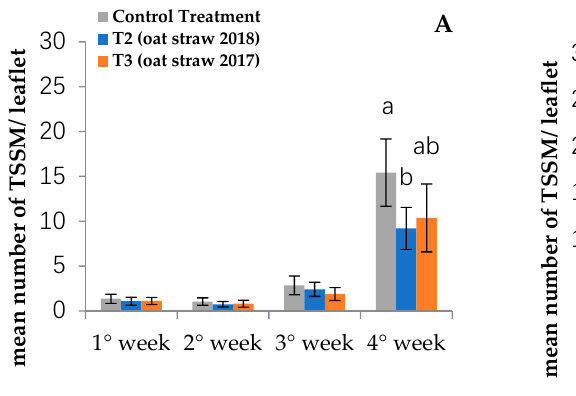
Figure 1. Weekly total numbers of Gamasina mites observed on six marked leaflets with Tetranychus urticae per plant ( n = 13 plants per treatment). A and B : ‘Early season’ experiment (T2, oat straw since 2018; T3, oat straw since 2017); C and D : ‘Mid-season’ experiment (T2, barley straw since 2018; T3, barley straw lower half layer since 2017 and top half layer since 2018). Light was on from 6 AM to 9 PM.